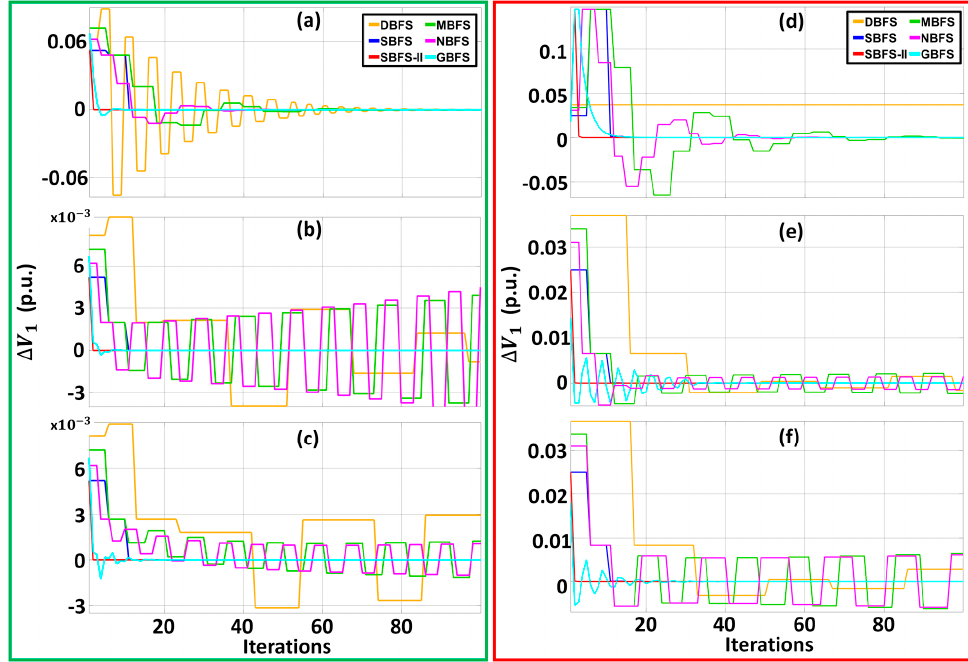
Figure 10. Convergence tests of ∆ V 1 for ( a ) Test 1—69-bus, ( b ) Test 2—69-bus, ( c ) Test 3—69-bus, ( d ) Test 1—118-bus, ( e ) Test 2—118-bus, and ( f ) Test 3—118-bus.